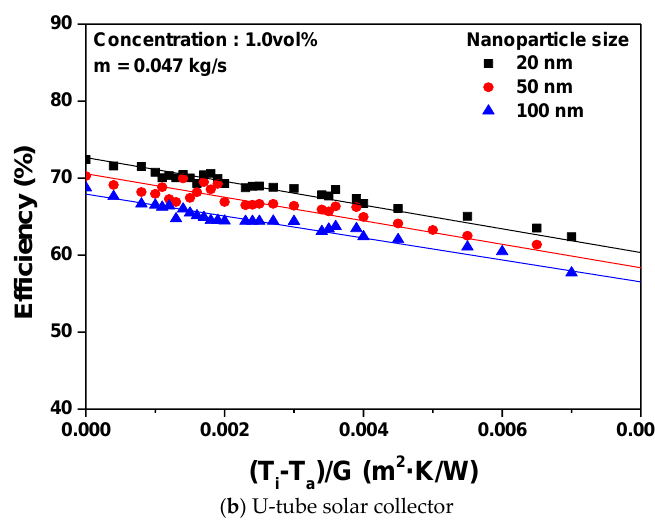
Figure 3. Efficiency variations in the solar collector for various nanoparticle sizes: ( a ) Flat-plate solar collector; ( b ) U-tube solar collector.